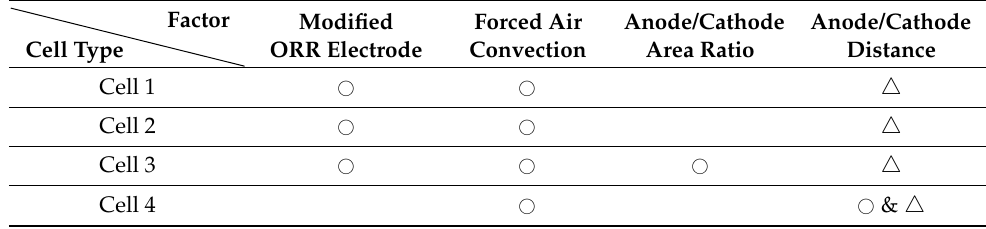
Table 1. Outline of experimental